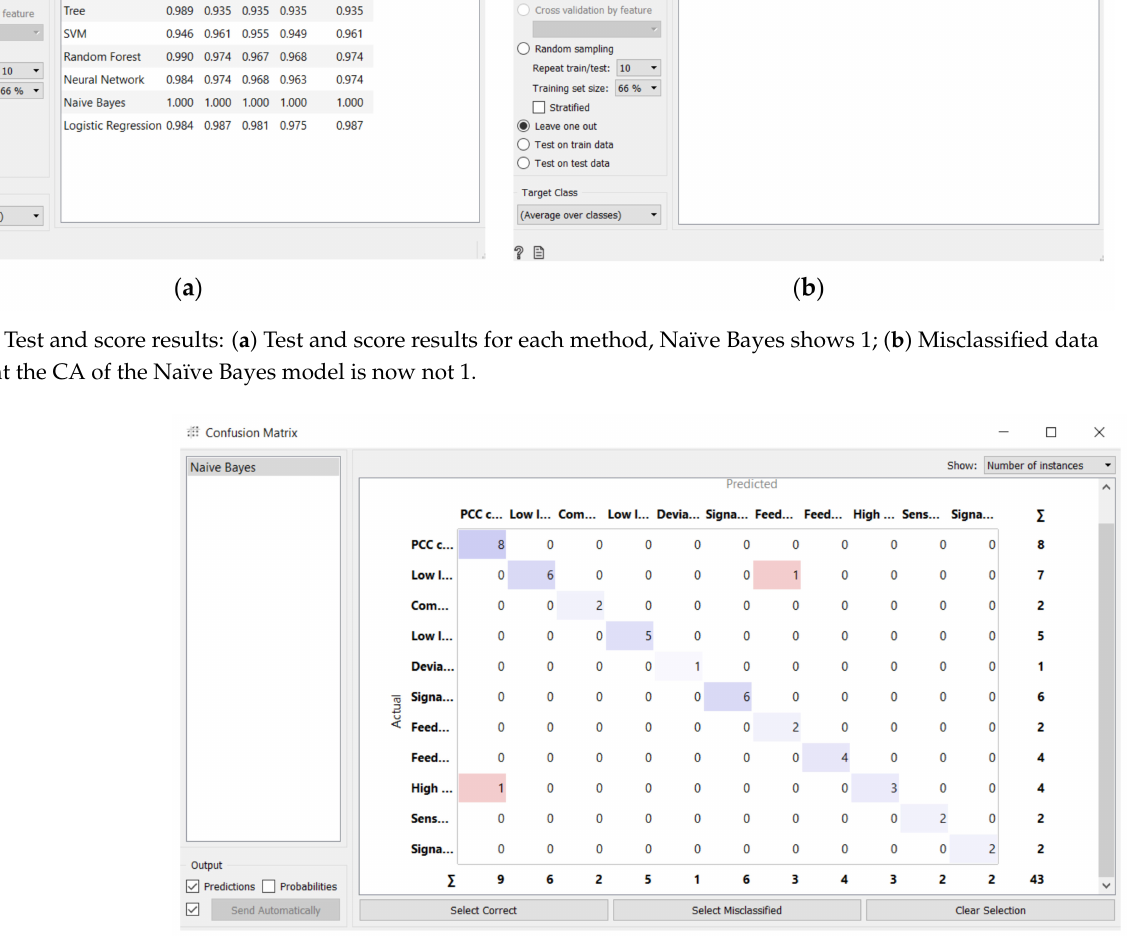
Figure 16. Confusion matrix shows and confirms 2 cases of incorrectly classified